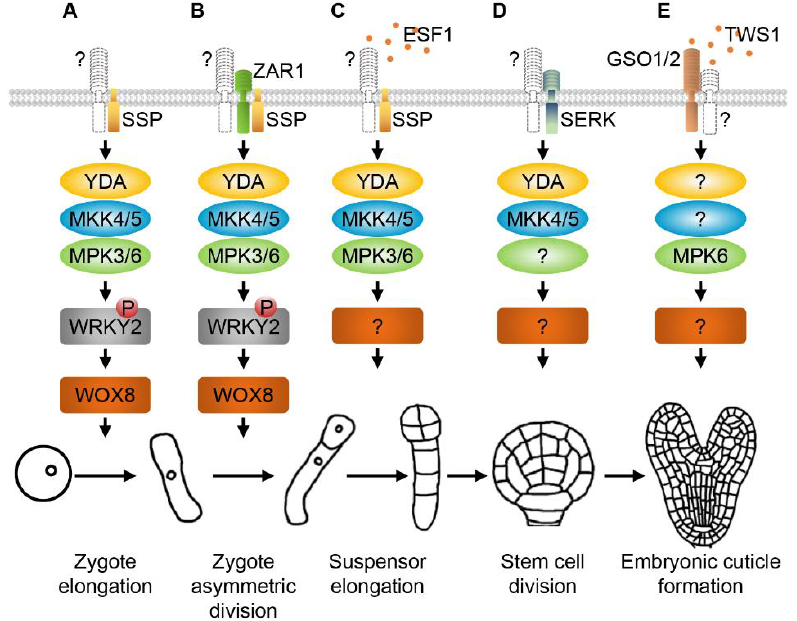
Figure 2. RLKs and MAPK cascades regulate embryo development. Membrane-associated receptor-like cytoplasmic kinase (RLCK) SHORT SUSPENSOR (SSP) regulates elongation of the zygote ( A ), asymmetric division of the zygote ( B ), and elongation of the suspensor ( C ) through the YDA-MKK4 / 5-MPK3 / 6 cascade. Leucine-rich repeat receptor-like protein kinase (LRR-RLK) ZYGOTIC ARREST 1 (ZAR1) is required to form a complex with SSP in controlling the asymmetric zygote division ( B ). The endosperm-secreted peptide EMBRYO-SURROUNDING FACTOR 1 (ESF1) regulates suspensor elongation together with SSP ( C ). A group of LRR-RLKs named SOMATIC EMBRYOGENESIS RECEPTOR-LIKE KINASES (SERKs) function upstream of YDA-MKK4 / 5 to control the division pattern of the ground tissue stem cells during early embryogenesis ( D ). The secreted peptide TWISTED SEED 1 (TWS1) is perceived by its receptor GASSHO1 / 2 (GSO1 / 2) to regulate embryonic cuticle formation through the YDA-MPK6 cascade ( E ). ? represents the unknown RLK, MAPK or transcription factor. P indicates the phosphorylation of WRKY2.